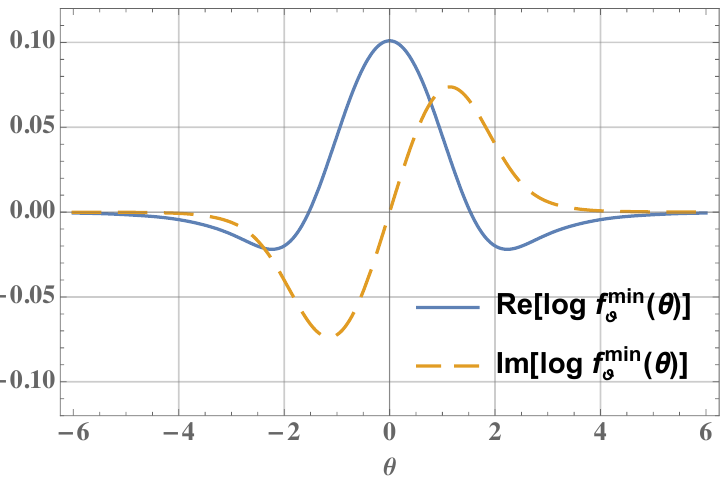
Figure 8. The one particle minimal form factor in the Sinh-Gordon theory for B = 0 : 5 and (cid:12) = 1. Contrary to the vacuum case, the one-particle form factor depends on the rapidity (cid:18) . The asymptote lim f min ( (cid:18) ) = j (cid:18) j!1 #